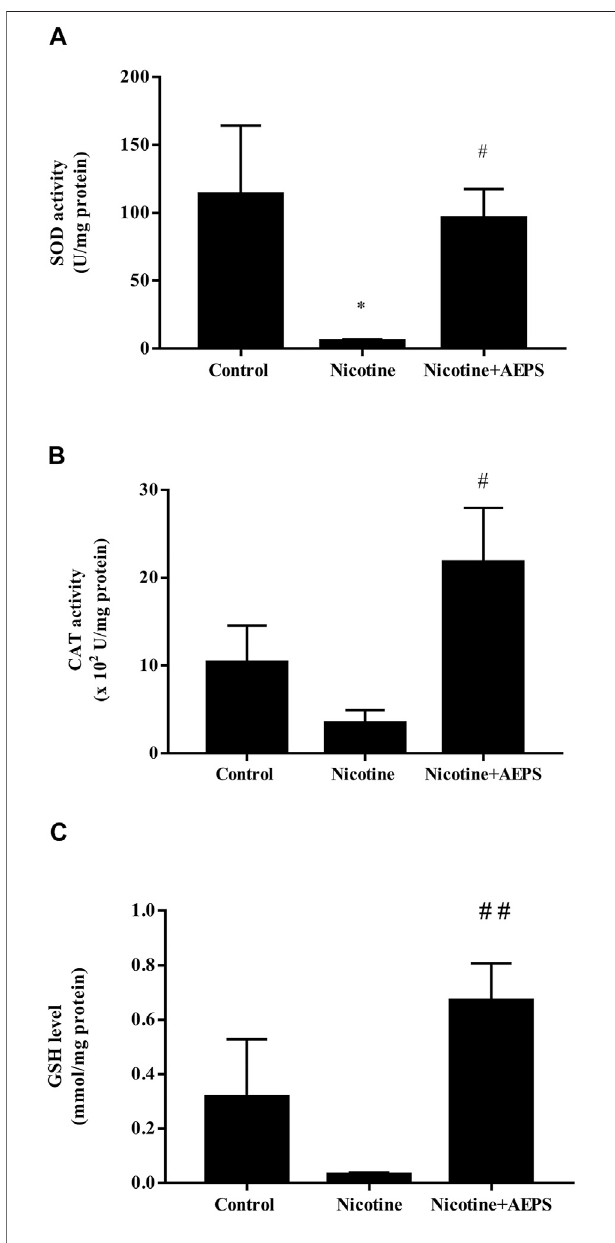
FIGURE 3 | Level of antioxidants (A) superoxide dismutase (SOD) activity (B) catalase (CAT) activity and (C) reduced glutathione (GSH) level in rat aortic tissues from each group. The values are given as mean ± SEM, n (cid:1) 6 – 8 for each group. * p < 0.05 compared with the control group, # p < 0.05, ## p < 0.01 compared with the nicotine